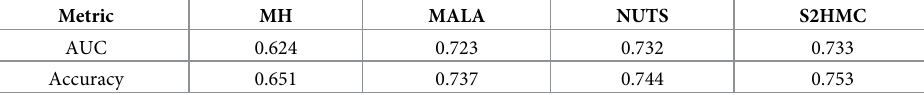
Table 3. Area under the receiver operating curve (AUC) and accuracy of the MCMC methods. The results were averaged over 10 runs of each algorithm.